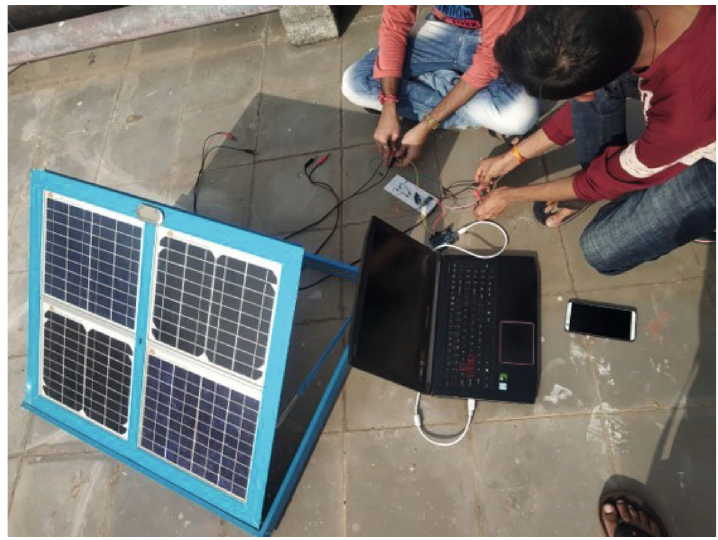
Figure 10: Setting up datalogger with roof-top panel to monitor performance data.